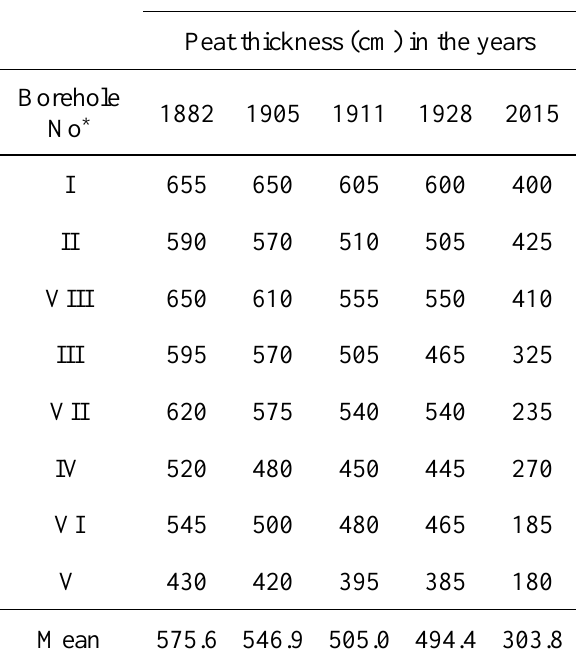
Table 1. Peat thickness loss in the years 1882–2015 along the A-B transect in Dublany peatland.